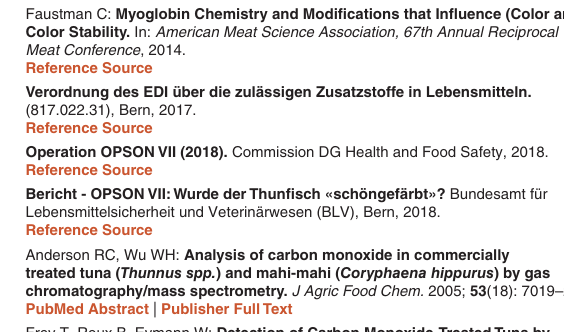
Niederer M: Fig03 brining experiment rawdata.csv. figshare. Dataset. 2019. http://www.doi.org/10.6084/m9.figshare.8142992.v1 10. Niederer M: Validation with Reference samples 2017. figshare. Dataset. 2019. http://www.doi.org/10.6084/m9.figshare.8143016.v1 11. Niederer M: Market survey 2019 rawdata. figshare. Dataset. 2019. http://www.doi.org/10.6084/m9.figshare.8143031.v1